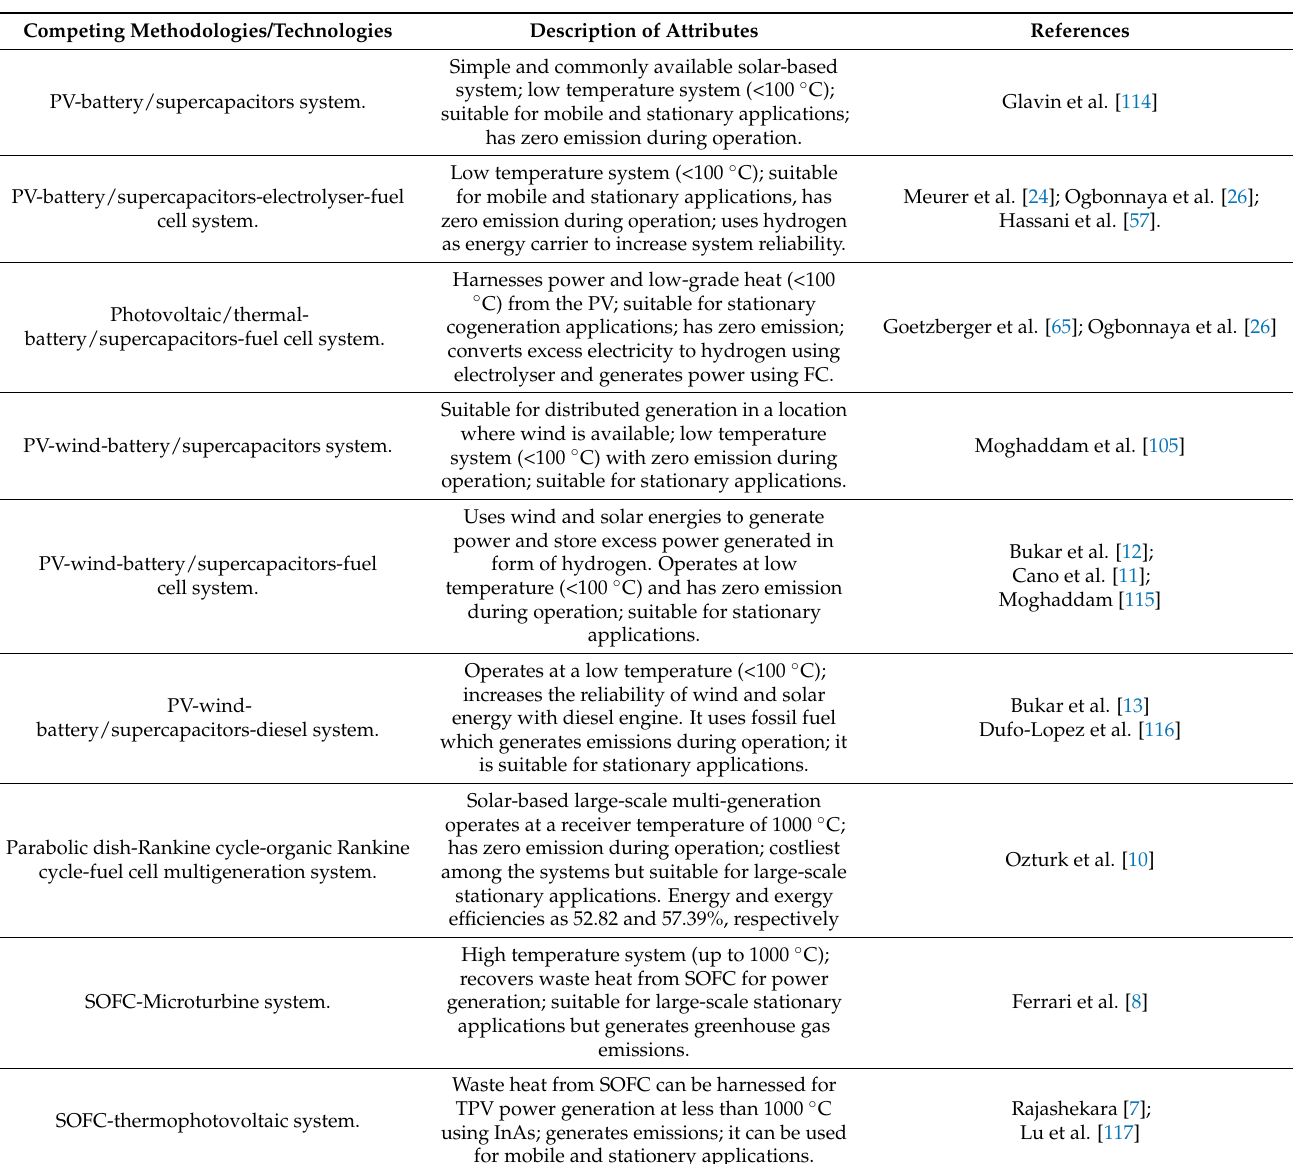
Table 3. Comparison between IPVFC systems with emerging competing